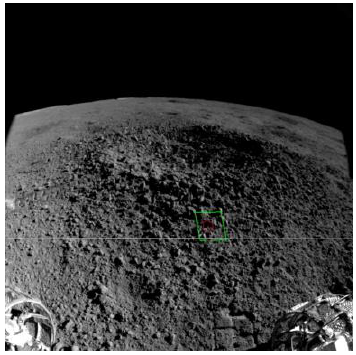
Figure 11. Predicted VNIS FOVs on Hazcam image at LE00907